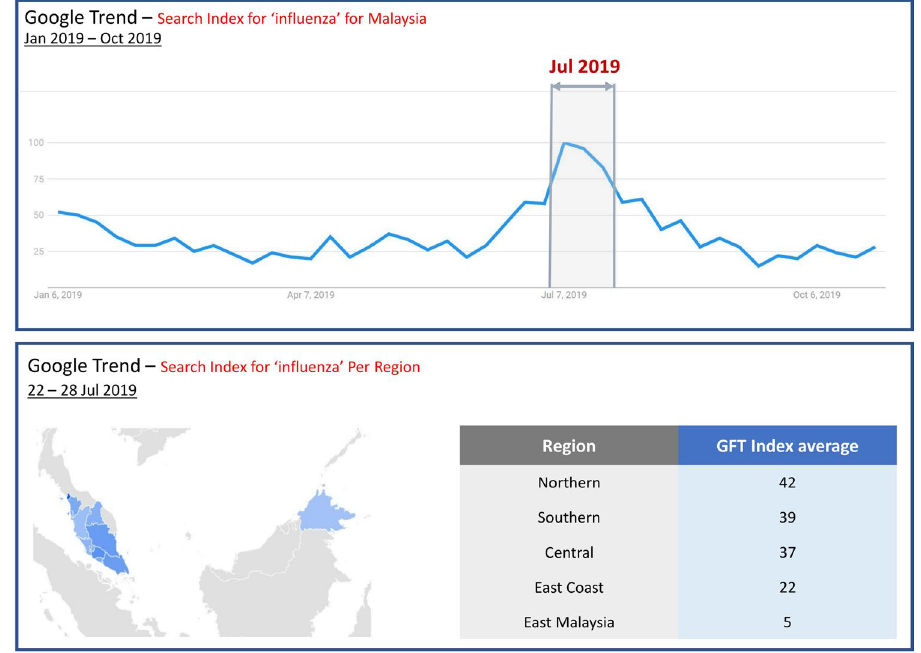
Figure 10. Google Flu Trend Result (week 22 – 28 Jul 2019) (Map screenshot from GFT website 23 ).